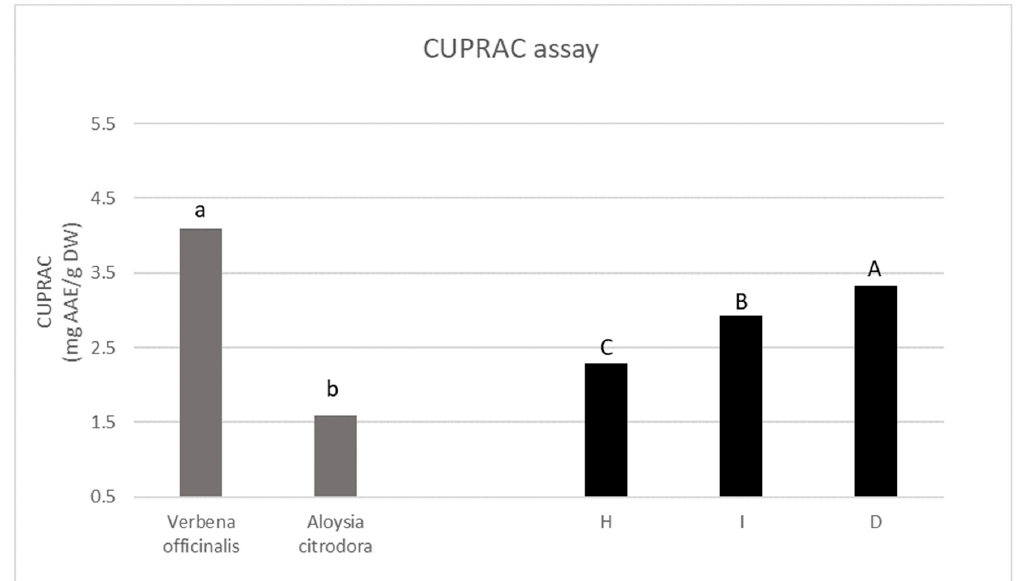
Figure 1. Antioxidant activity of the hydromethanolic extract (H), infusion (I), and decoction (D) of Verbena officinalis and Aloysia citrodora. Different small letters above each bar indicate significant differences between the extracts of Verbena officinalis and Aloysia citrodora at p < 0.05 while different capital letters above each bar indicate significant differences between the different extracts at p < 0.05. Ascorbic acid was used as a positive control (57.85 mg ascorbic acid equivalent (AAE) per g DW).